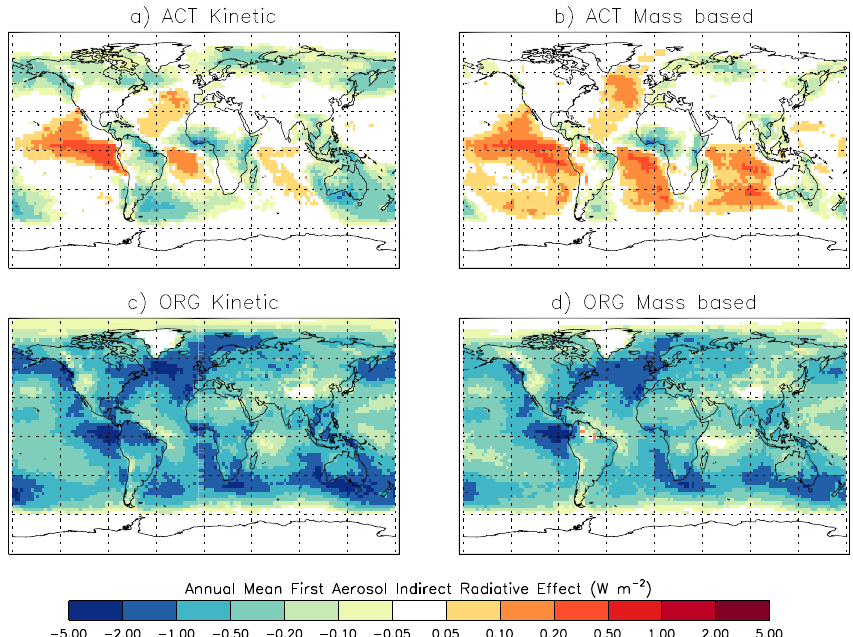
Figure 3. Annual mean first AIE (Wm − 2 ) from biogenic SOA in GLOMAP when SOA is distributed according to the kinetic approach (a and c) and the mass-based approach (b and d) . Simulations use either an activation (a and b) or organically mediated (c and d) new particle formation mechanism. Table 3. Global annual mean change to cloud droplet number concentration (CDNC), calculated using five globally uniform updraught velocities, in the model level which corresponds to low-level cloud base (mean pressure of approximately 900hPa), and first aerosol indirect effect (AIE), reported to two decimal places, resulting from the inclusion of biogenic SOA in GLOMAP using the kinetic and mass-based approaches. The mean values are calculated assuming that all updraught velocities are equally likely. Nucleation